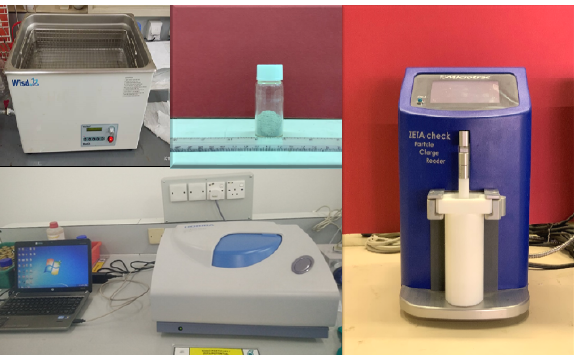
Figure 7. Zeta potential (ZP) measurements; Zeta-sizer (SZ-100) ( bottom left ), the ultrasonic bath ( top left ), and Zeta-check (Particle Matrix GmbH) ( right